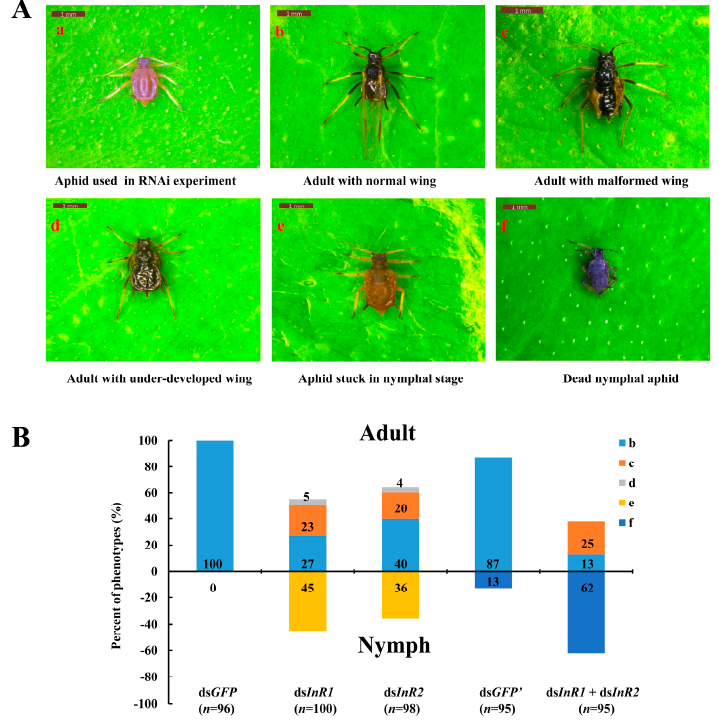
Figure 4. Representative phenotypes of alate A. citricidus after feeding on ds InR1 or ds InR2 , and the mixture of ds InR1 and ds InR2 for 72 h. ( A ) Phenotypes were presented in RNAi experiment; ( a ) Fourth instar winged-nymphs treated by dsRNA; ( b ) Adult with normal wing after RNAi; ( c ) Adult with malformed wing after RNAi; ( d ) Adult with under-developed wing after RNAi; ( e ) Aphid stuck in nymphal stage after RNAi; ( f ) Dead individuals in nymphal stages after RNAi; ( B ) the rate of presented phenotypes. “ n ” means the number of aphids in the treatment. ds GFP means the dsRNA concentration of the treatment was 1500 ng/ μ L and ds GFP ’ means the dsRNA concentration of the treatment was 3000 ng/ μ L .